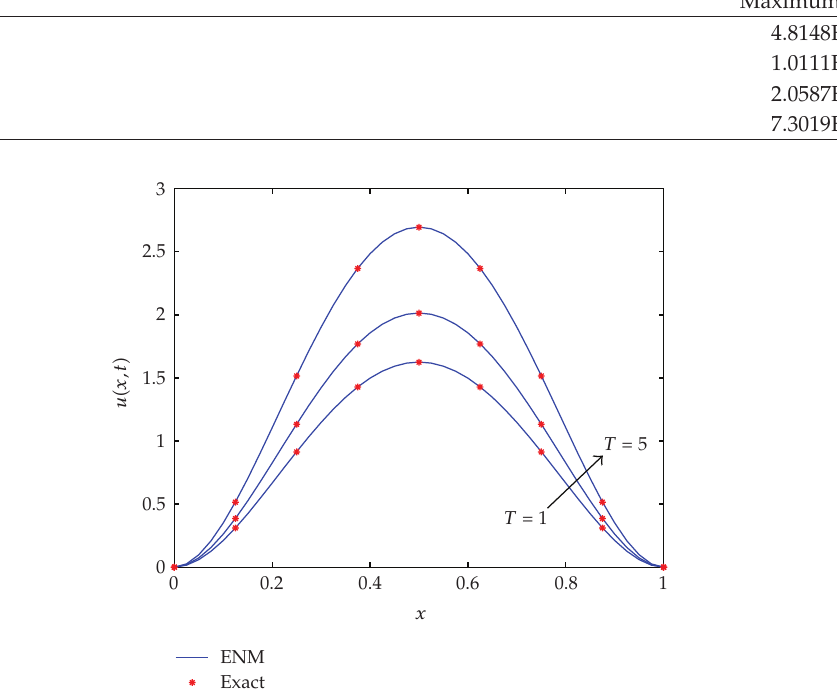
Figure 1: Comparison of the numerical solution with the exact solution for Example 5.1 at T (cid:7) 1 . 0 , 3 . 0 , 5 . 0. T increases in the direction of the